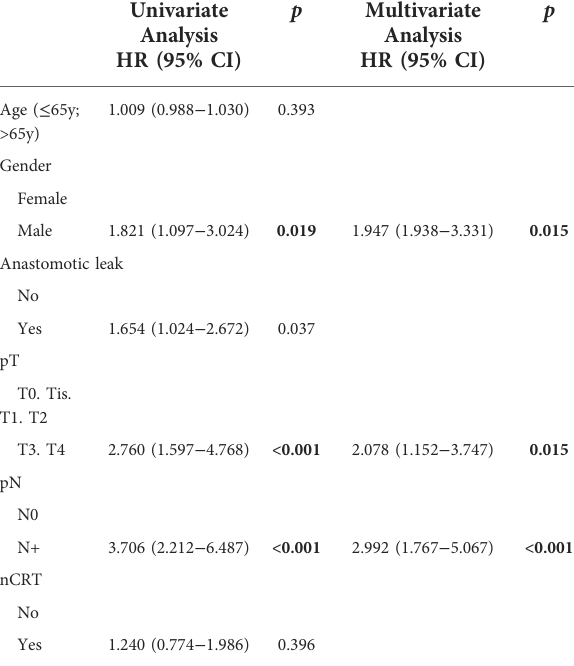
TABLE 5 Univariate and Multivariate analysis of Disease-free survival.